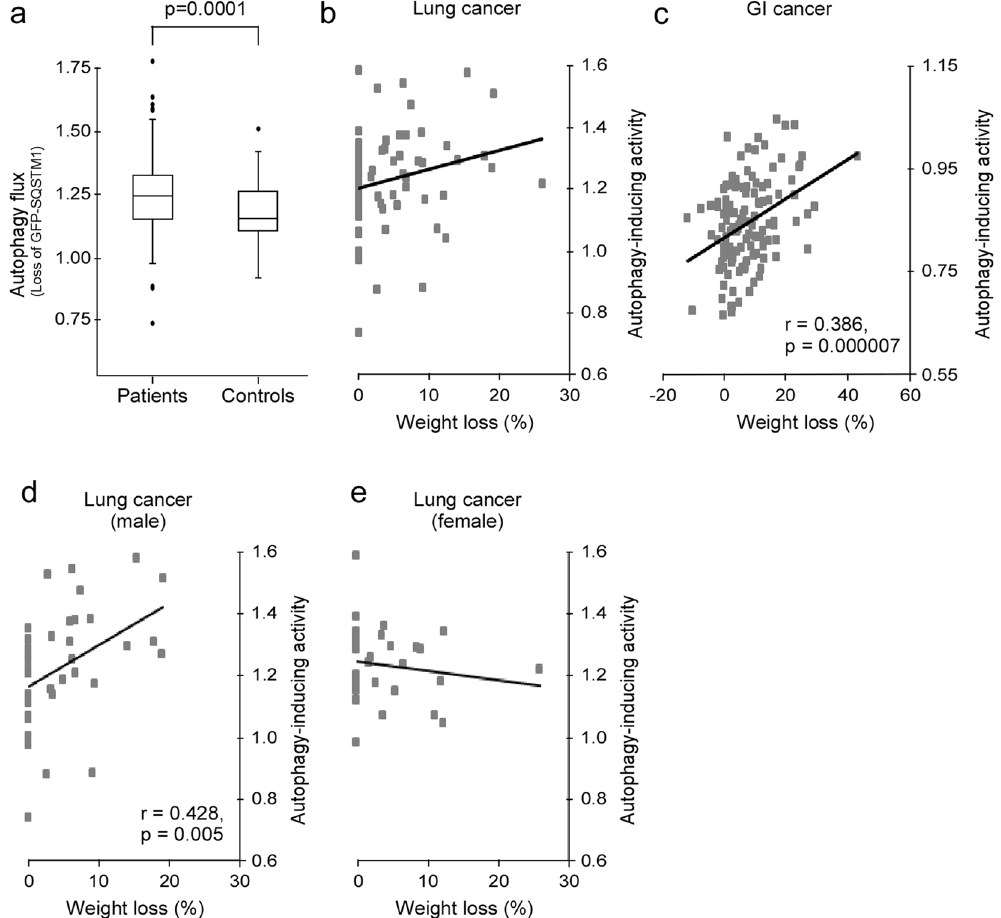
Figure 1. Blood samples from cancer patients with weight loss harbor autophagy-inducing bioactivity. ( a ) Autophagy flux in reporter cells exposed to sera from lung cancer patients (n = 79) or healthy controls (n = 148) (Student t-test). ( b ) Weight loss (% loss during 3 months prior to blood sampling) in lung cancer patients and autophagy-inducing activity in their sera, measured using an autophagy reporter cells system. ( c ) Weight